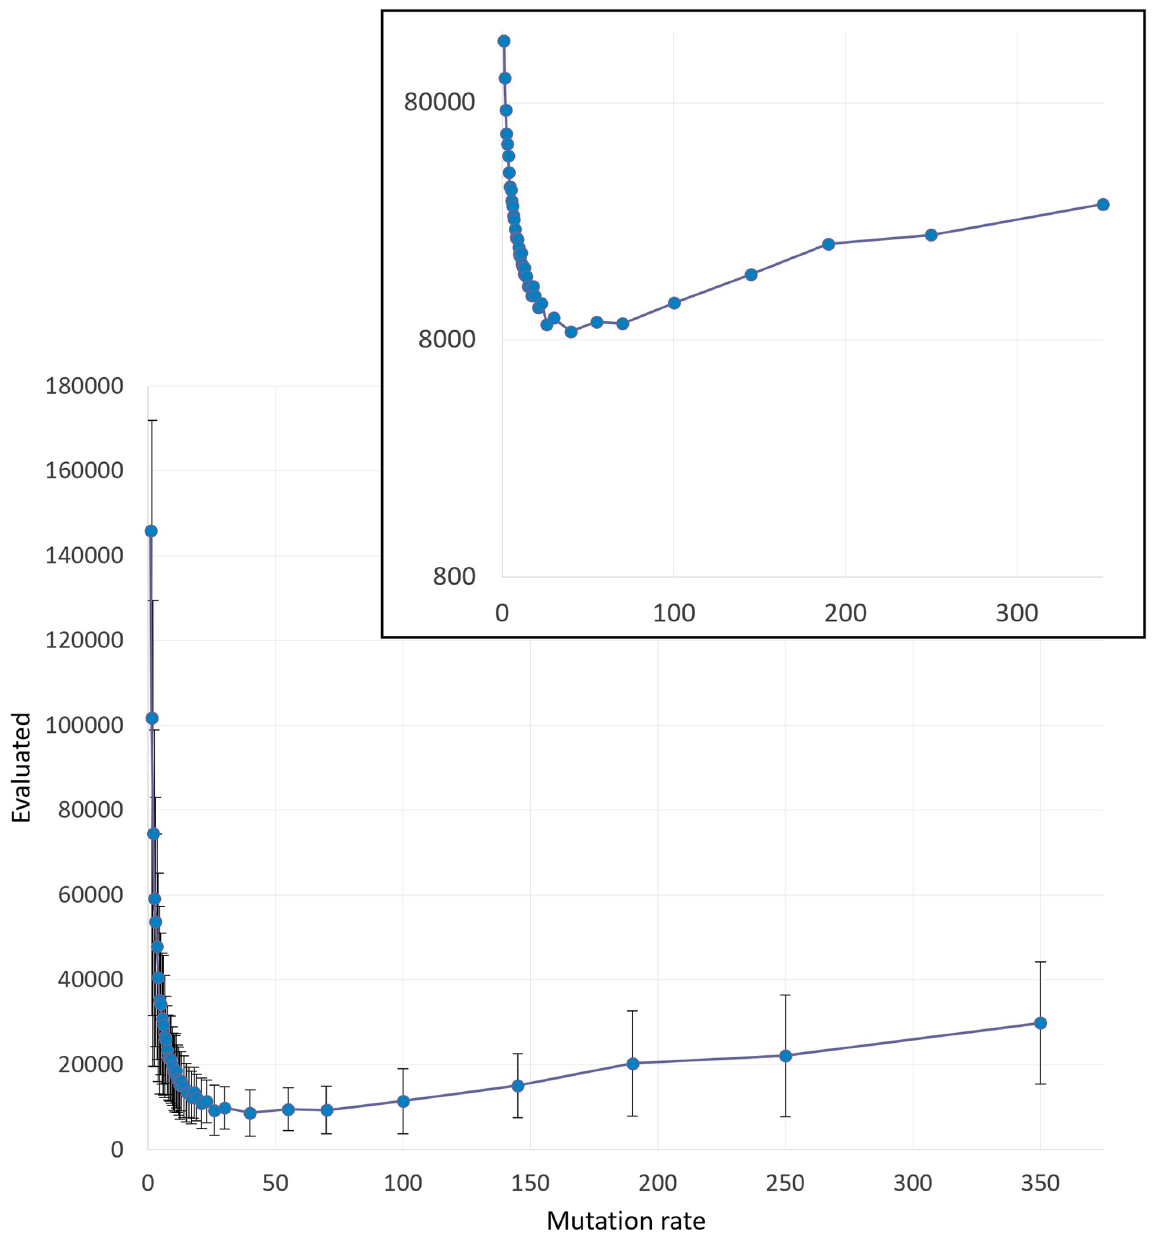
Fig 8. RMHC: Effectiveness vs mutation rate. Simple consensus-based BioRS (4 domains, 6+4 defined positions out of 26, W = 220). The mean number of fitness evaluations are computed over 200 runs per test. Standard deviations are shown as vertical bars. Inset is presented in logarithmic